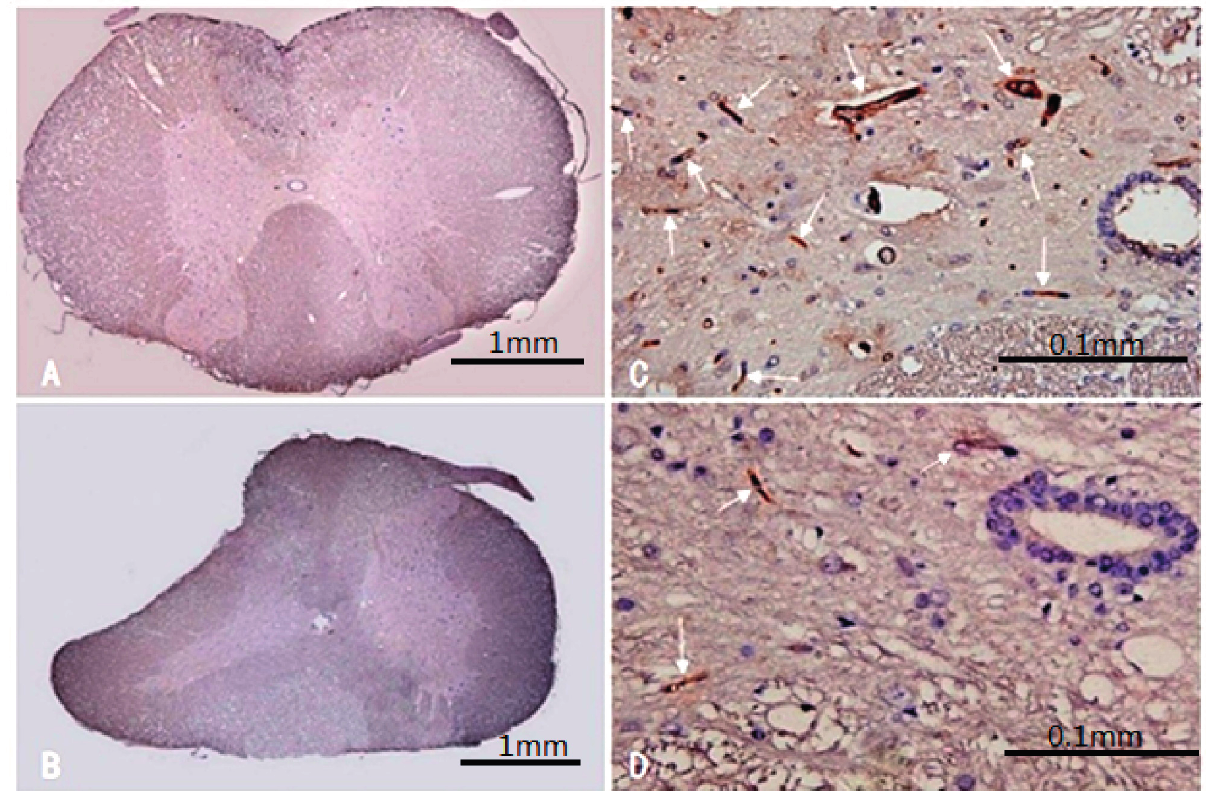
Figure 3. CD34 immunohistochemical staining in normal and compressed spinal cord segment. ( A ) Normal spinal cord contour in control group (×4); ( B ) CD34-positive vascular endothelial cells sparsely distributed in the gray matter at high magnification in control group (×40); ( C ) deformedspinal cord contour in compressed group (×4); ( D ) compression spinal cord section at high magnification, microvascular density in gray matter decreased (×40). “ → ” shows the